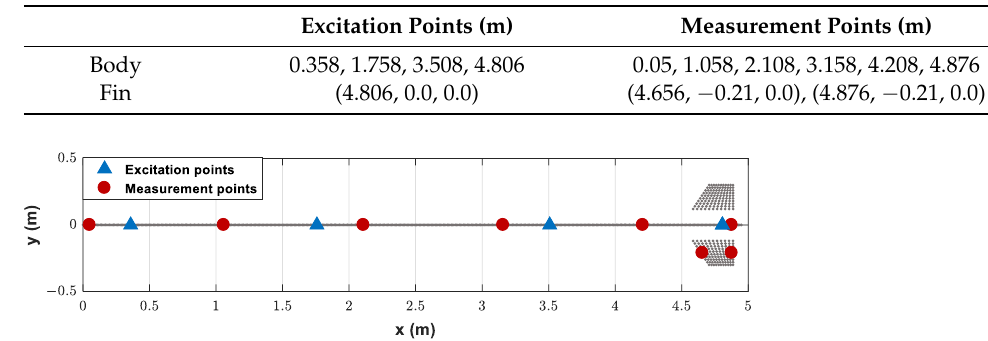
Figure 18. Locations of excitation and measurement points.